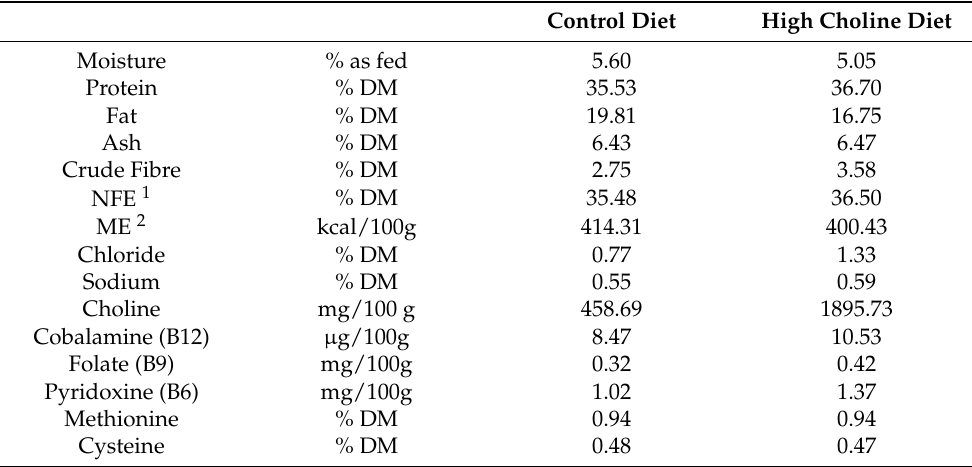
Table 1. Proximate analysis and dietary analyses of chloride, sodium, selected B-vitamins and amino acids of two experimental diets: a control diet and a high choline diet